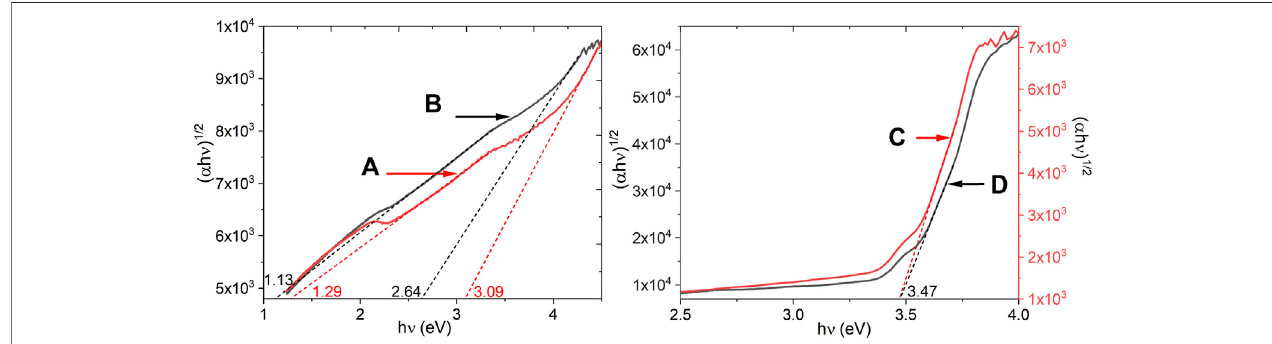
FIGURE 7 | Variation of ( α h ν ) 1/2 with h ] for (A) PEDOT:PSS-graphene- a complex, (B) PEDOT:PSS-graphene- b complex, (C) PEDOT:PSS-graphene- a -BPhen, and (D) PEDOT:PSS-graphene- b -BPhen fi